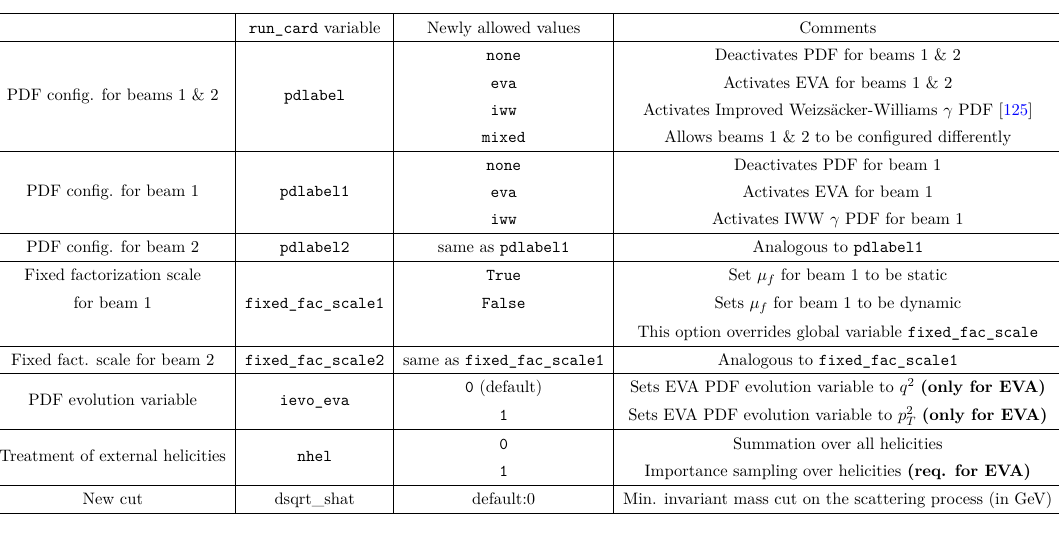
Table 8 . The list of the important and/or new parameters introduce into mg5amc to support PDFs for polarized EW gauge bosons (EVA) from high-energy leptons. See text for further details.